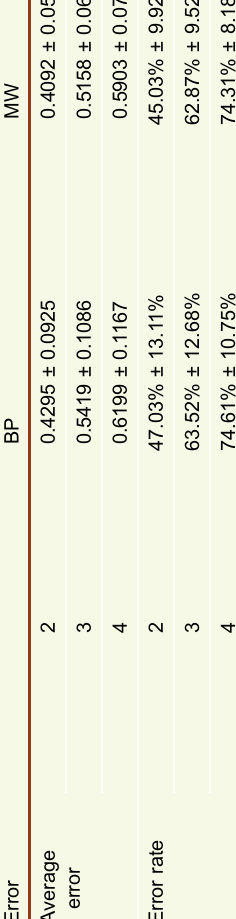
Table S14). The number of iterations that occurred when RCR reached 0.45 are shown for each method as follows: